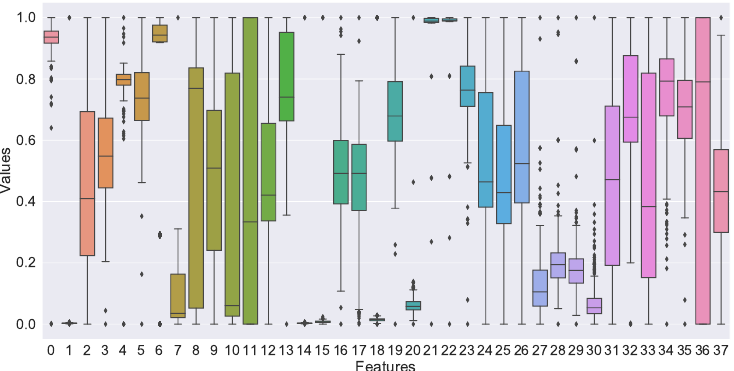
Figure 11. The box diagram of the selected